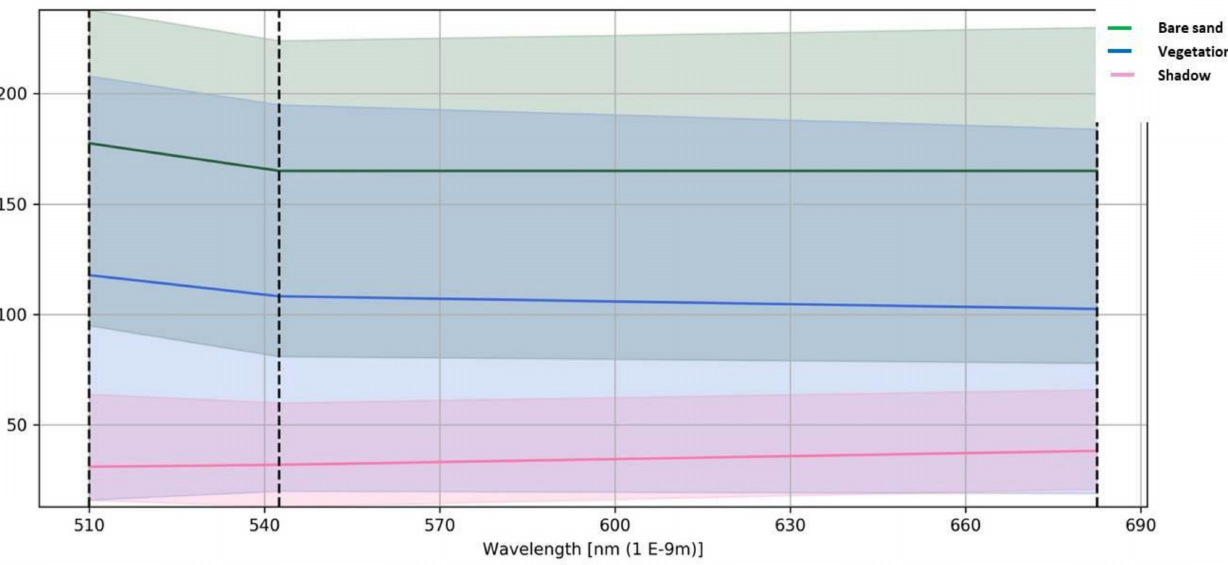
Figure 3. Spectral information plot from SCP: continuous colored lines represent the average value of each spectral information class; dashed lines indicate the average value for each wavelength, red (682.5 nm), green (542.5 nm) and blue (510.0 nm); on the ordinate spectral signature values (dimensionless) are